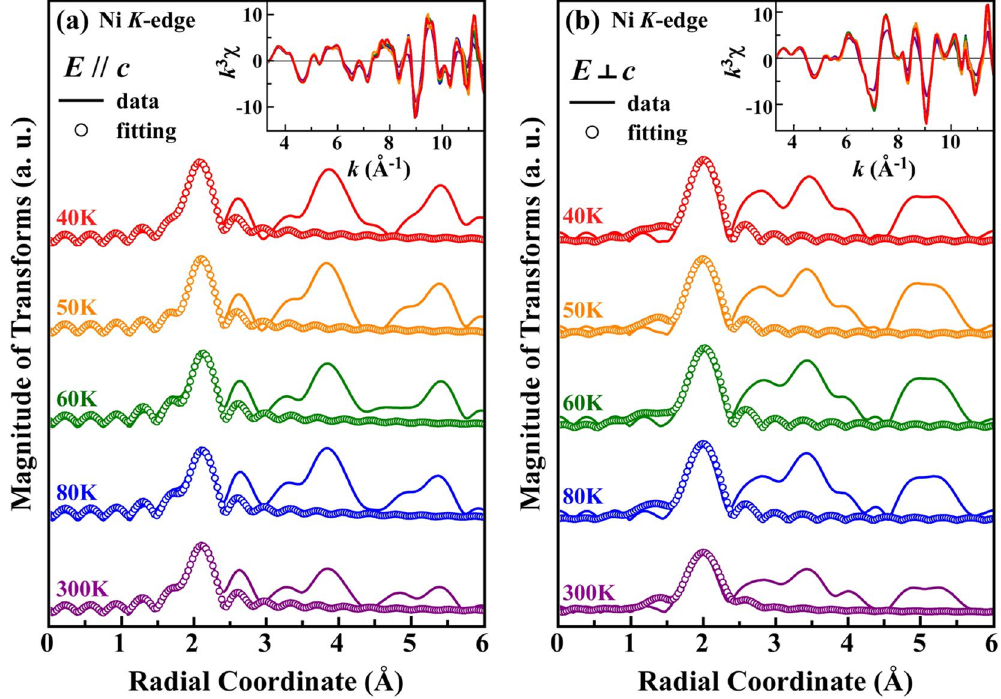
Figure 6. Magnitude of the FT spectra of the temperature-dependent Ni K- edge EXAFS for ( a ) E // c and ( b ) E ⊥ c , with corresponding k 3 -weighted k 3 χ vs. k plots in the k range of 3.3–11.6 Å − 1 shown in the respective insets. The first main FT feature (near R ~ 2 Å) corresponds to the mean NN Ni-O bond length within the NiO 6 octahedra in